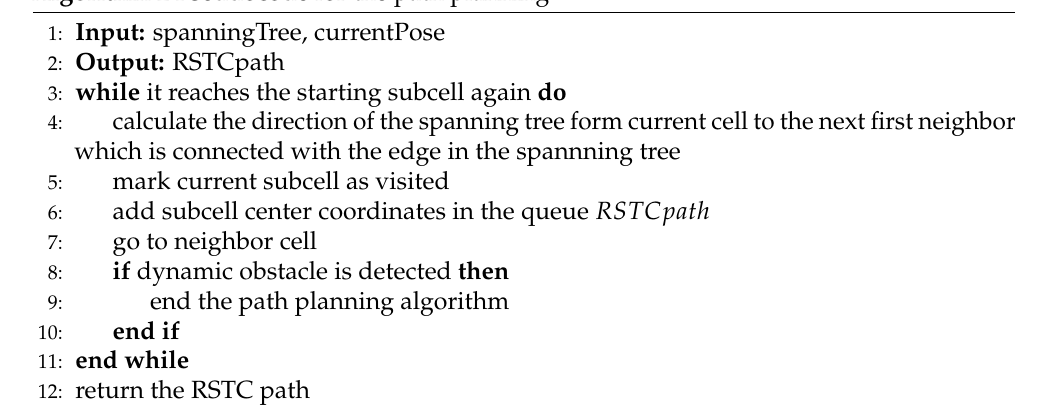
Algorithm 2 Pseudocode for the path